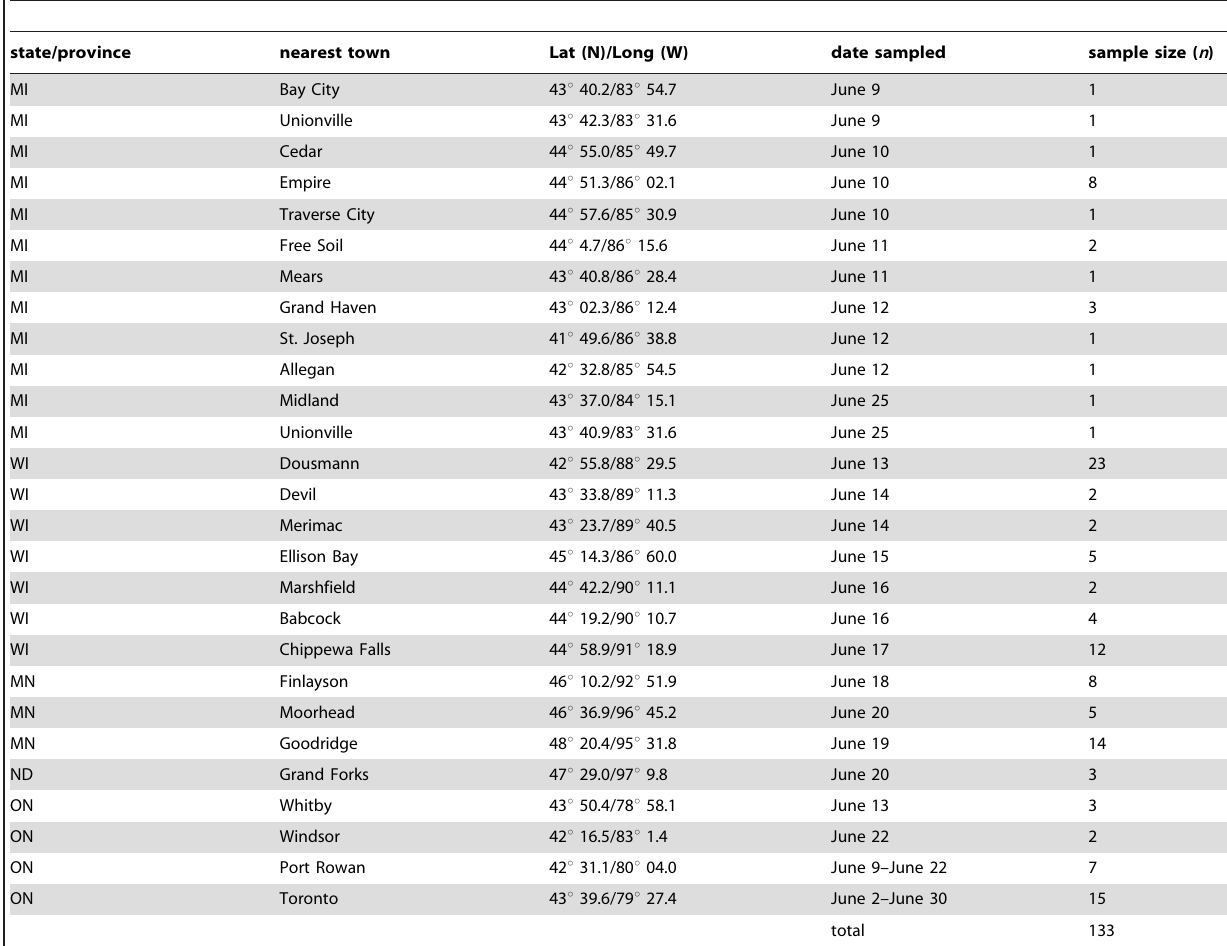
Table 2. Monarch sampling sites throughout the Great Lakes region from June 2 to June 30, with information on sampling location (state/province, nearest city, and GPS coordinates), dates, and sample size.